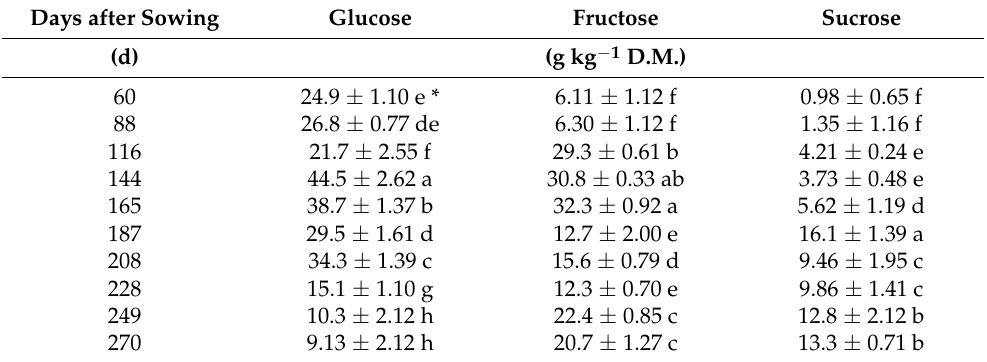
Table 2. Glucose fructose and sucrose (g kg − 1 D.M.) variations during the growth cycle of wild cardoon. Days after Sowing Glucose Fructose Sucrose (d) (g kg − 1 D.M.)